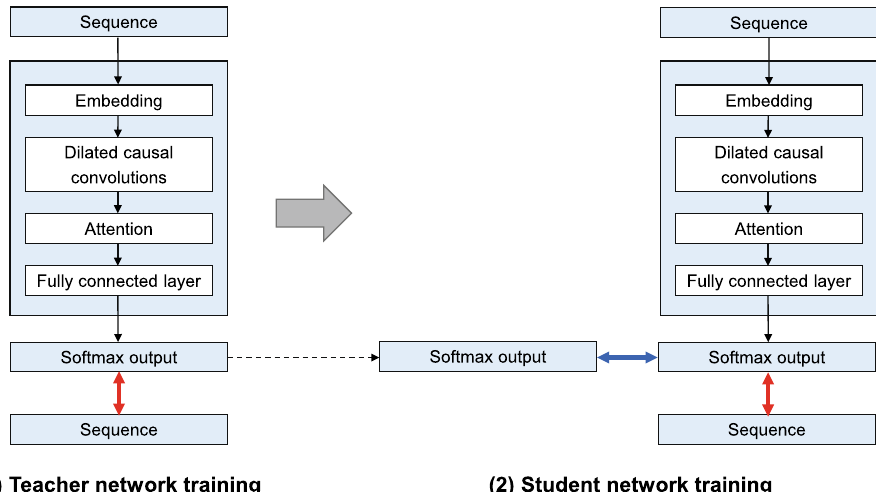
Figure 1. MTBAN model structure. We implemented BAN with mutationTCN as both the teacher and the student network. In the first step, only the teacher network is trained, with the loss function being the label loss (red arrow), which refers to the cross entropy loss between the input sequence and the softmax output distribution of the teacher network. In the second step, only the student network is trained, with the loss being the sum of the label loss (red arrow) and the teacher loss (blue arrow). Here, the label loss refers to the cross entropy loss between the input sequence and the softmax output of the student network. The teacher loss refers to the cross entropy loss between the softmax output of the student network and the “softened” output distribution of the teacher